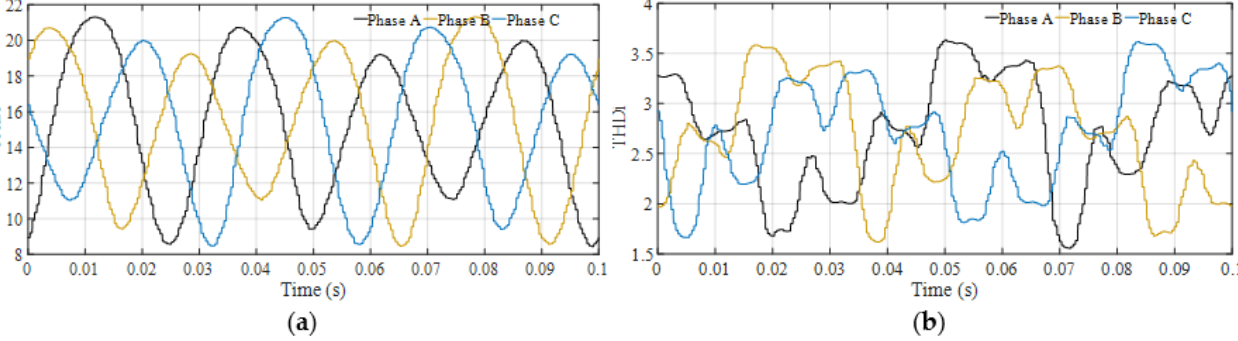
Figure 28. Total harmonic distortion of the current (THDi). ( a ) Deformed by harmonic and ( b ) operating EVs as active filter.